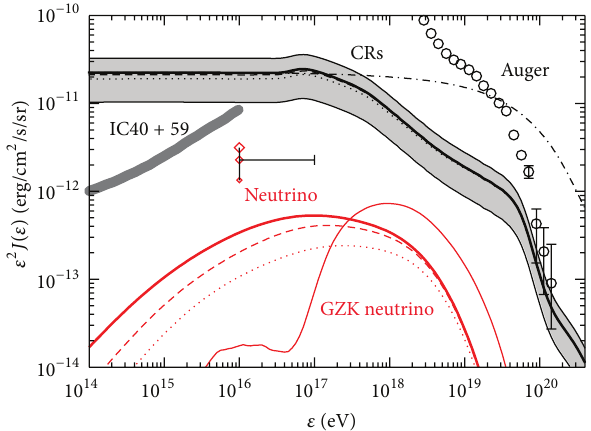
Figure 2: CR (black) and neutrino diffuse intensities in the model calculation in the work of Asano and M´esz´aros